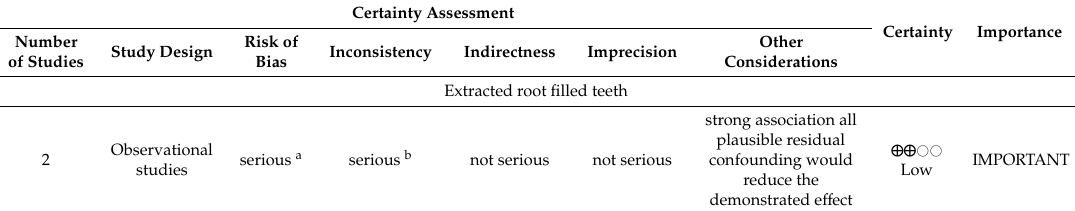
Table 4. GRADE Working Group grades of evidence: Smoking habits and the prevalence of root filled teeth